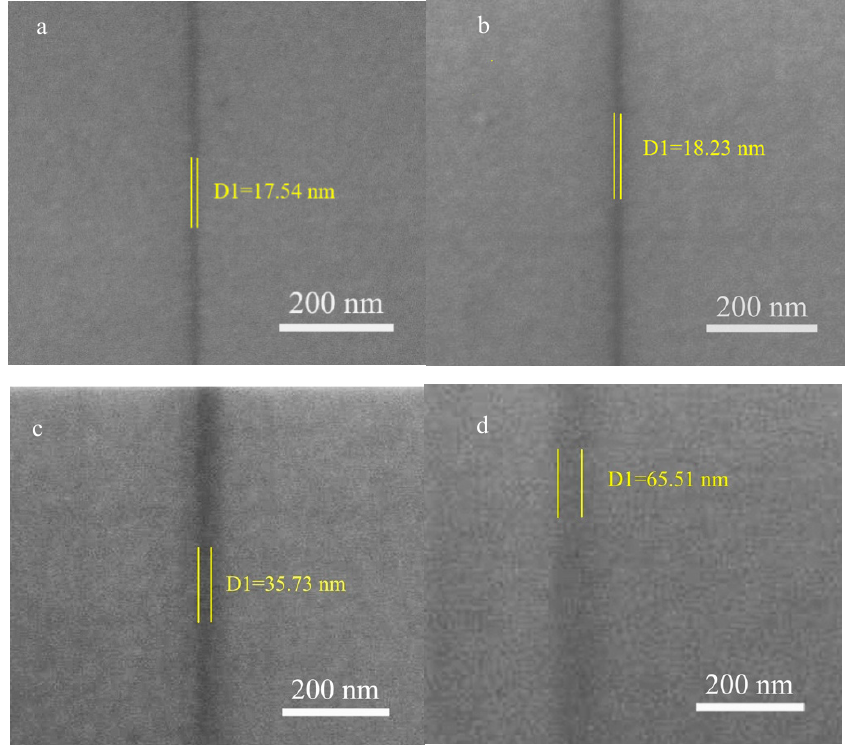
Figure 8. SEM scanning of RNFP development results. ( a , b ) are development results for the aluminum reflector, ( c ) is the development result for the chromium reflector, ( d ) is etching result without the aluminum reflector.